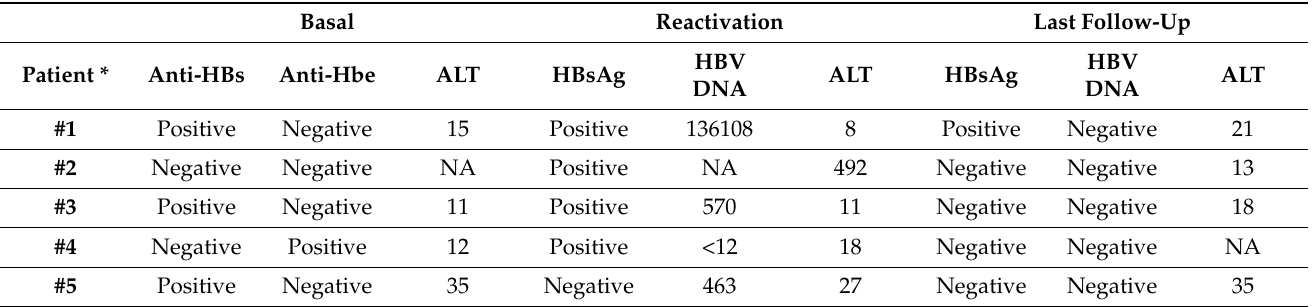
Table 4. Hepatological characteristics of reactivated patients ( n =